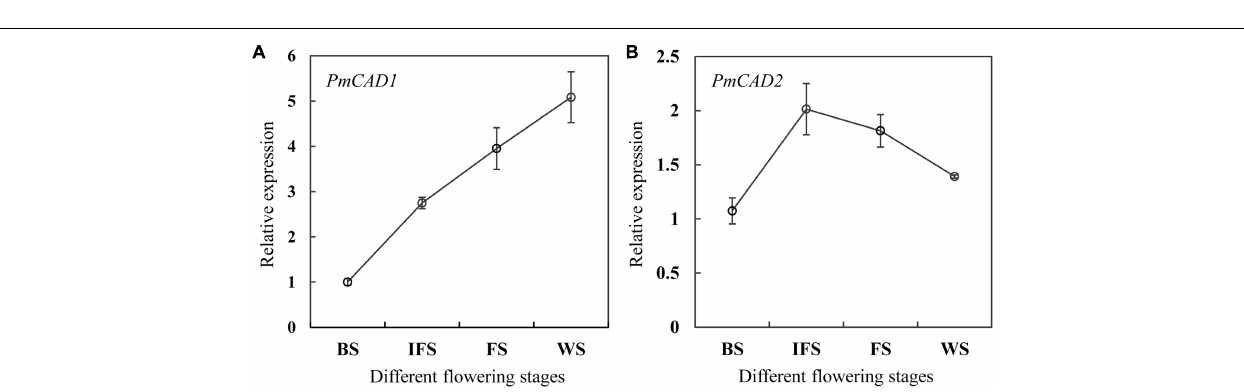
FIGURE 5 | Expression patterns and sequence analyses of candidate PmCADs . (A) Expression patterns in five tissues (SRP014885); (B) expression patterns during the budding stage and full-blooming stage in transcriptome data sets (PRJCA000274). The RPKM values were log10 transformed. (C) Phylogenetic tree analysis of CAD amino acid sequence in P. mume and other species. (D) Multiple sequence alignment analysis of CADs in P. mume and other species. Their conserved domains were boxed and marked in the red box. GenBank annotation numbers are listed in Supplementary Table 2 .